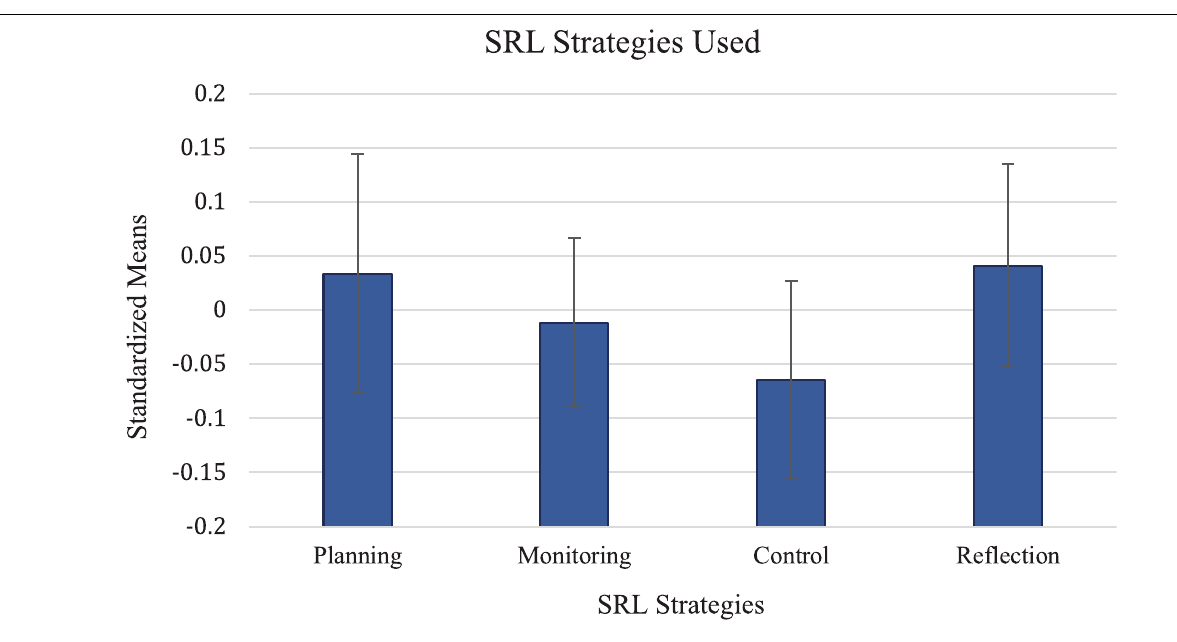
FIGURE 2 | Standardized means of individual SRL strategies